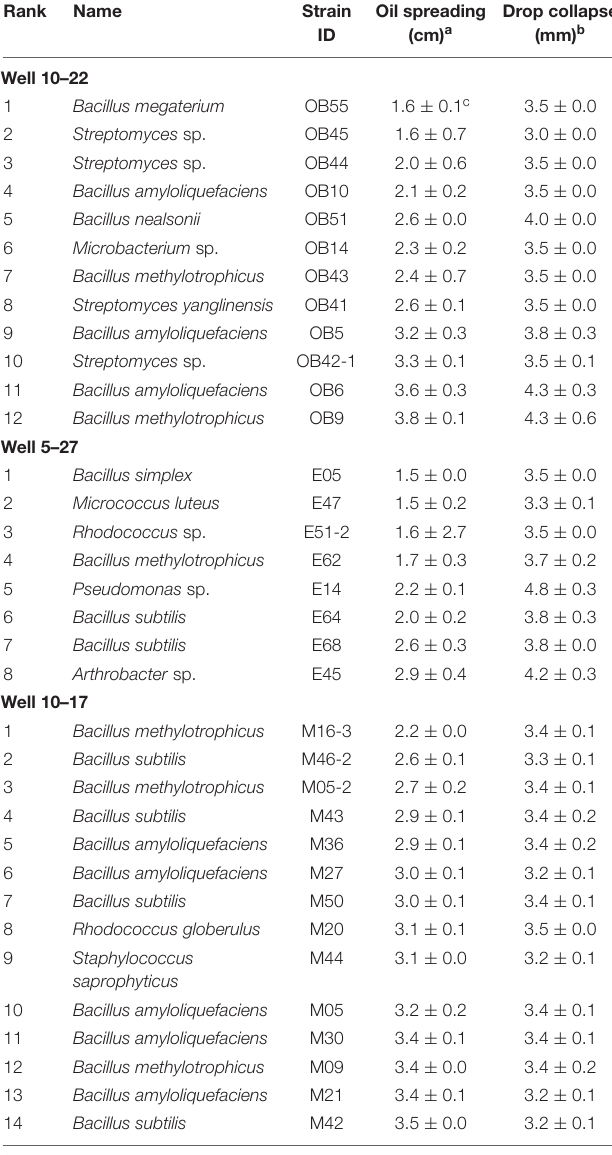
TABLE 2 | Top biosurfactant-producing isolates of three oil wells 10–22, 5–27,